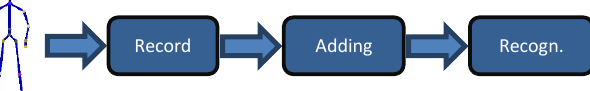
Figure 1. Sequence for capturing and recognizing of gestures.